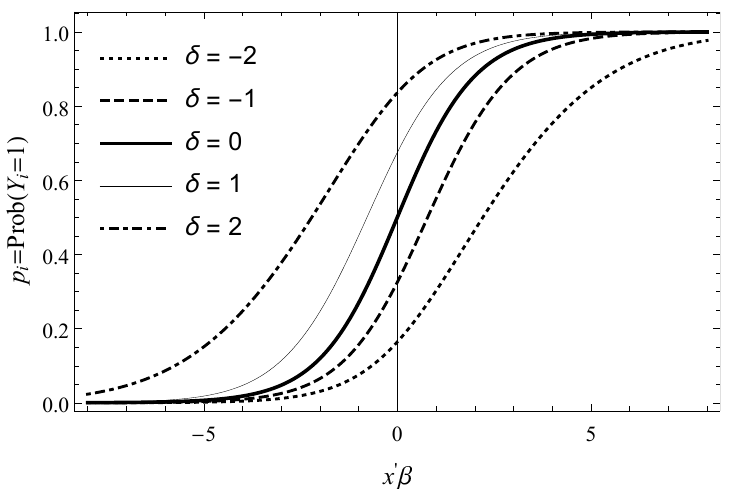
Figure 1. Cumulative density function (logistic kernel mean function) of the skewed logit model for special values of skewness parameter δ . The case δ = 0 corresponds to the classical logistic